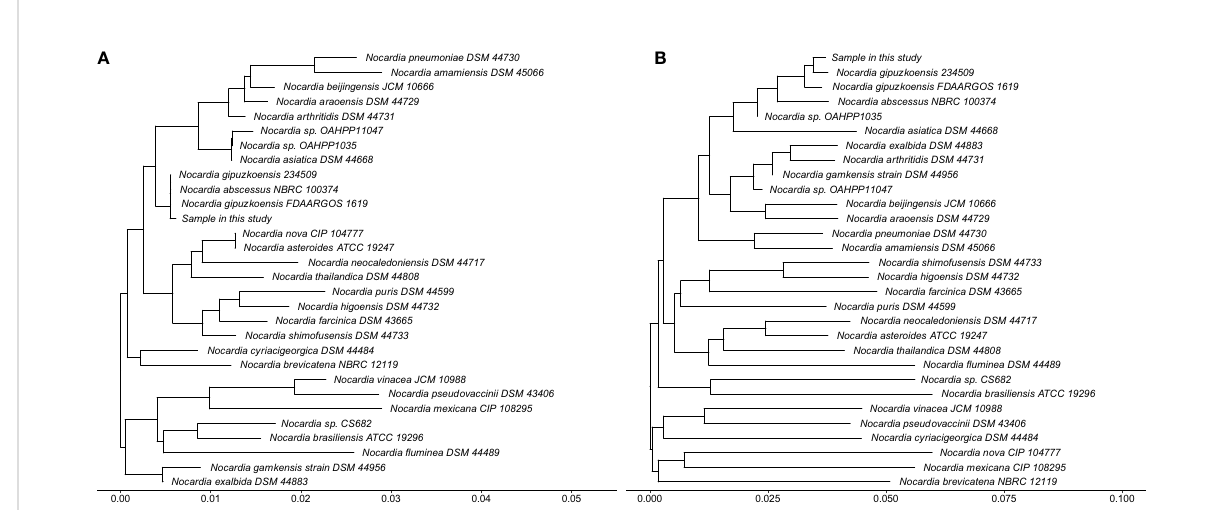
FIGURE 4 The coverage map of N. gipuzkoensis .